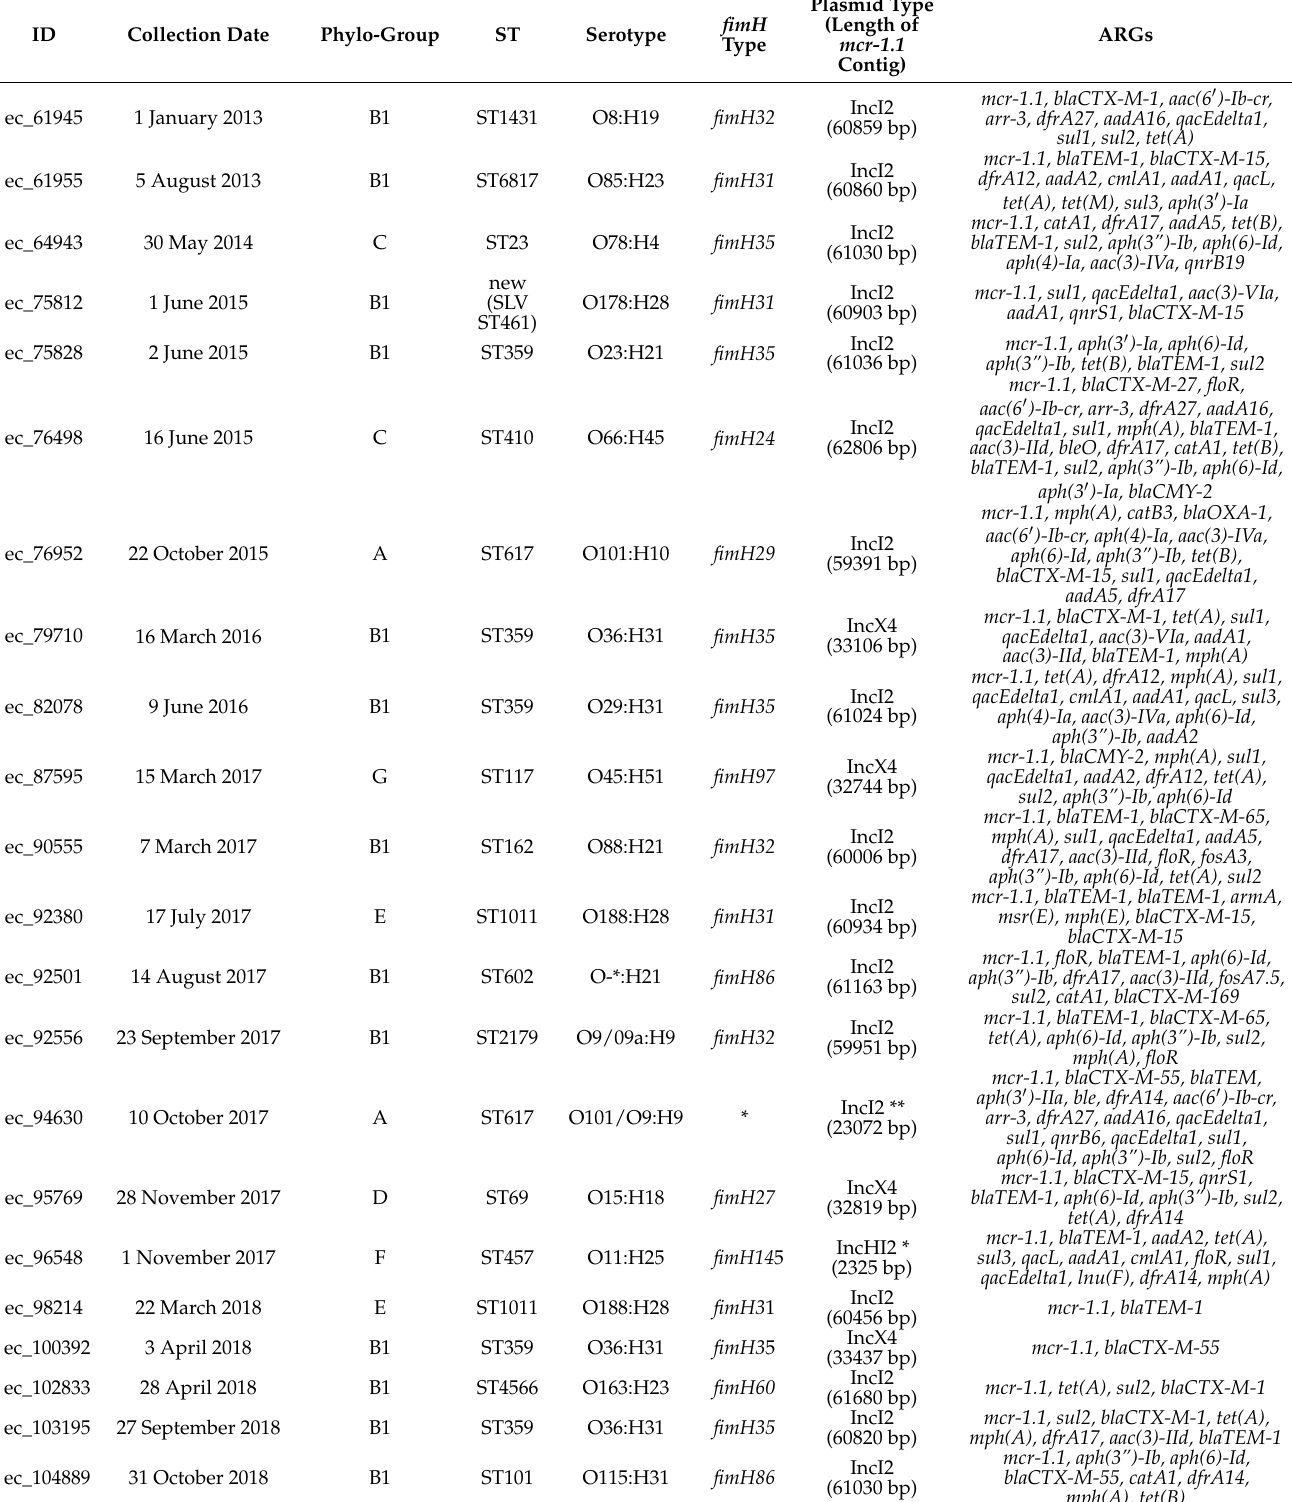
Table 1. Characteristics of mcr- positive E. coli